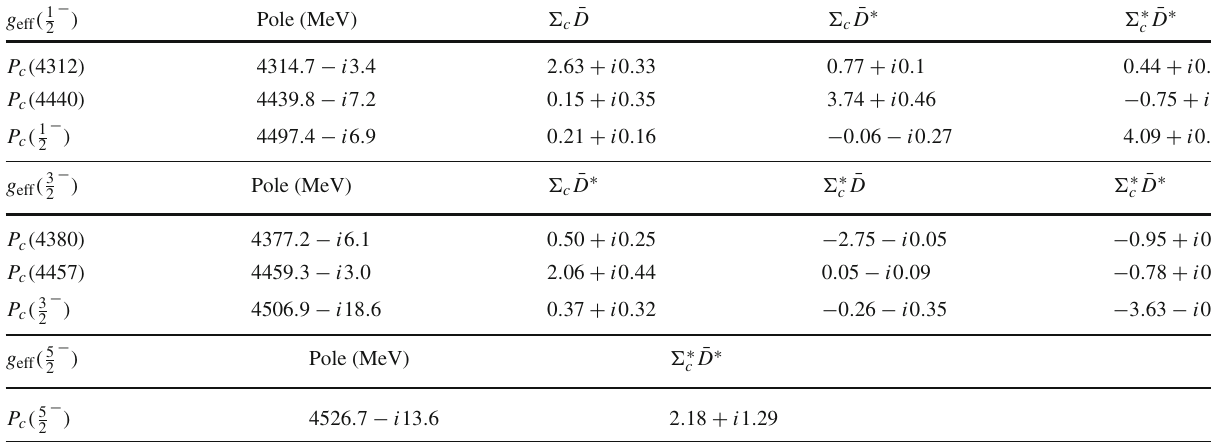
Table 2 The effective couplings of each channel for the three 1 second row is the corresponding pole positions. These values are taken from Ref.